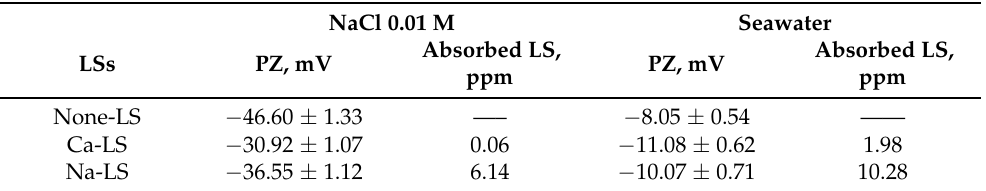
Table 6. Zeta potential of Molybdenite and LSs adsorption on molybdenite in NaCl 0.01M and seawater. Using 10 ppm of